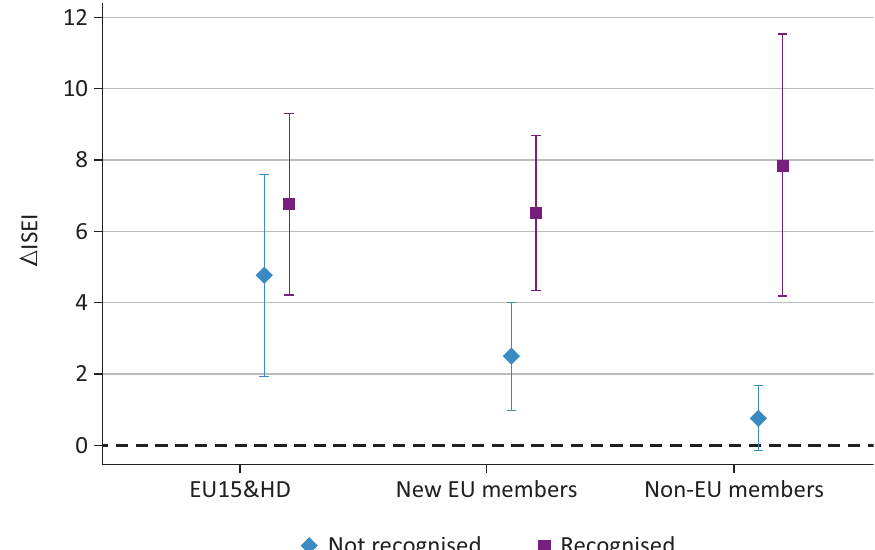
Figure 4. Returns to post-secondary degree by origin and recognition on Δ ISEI